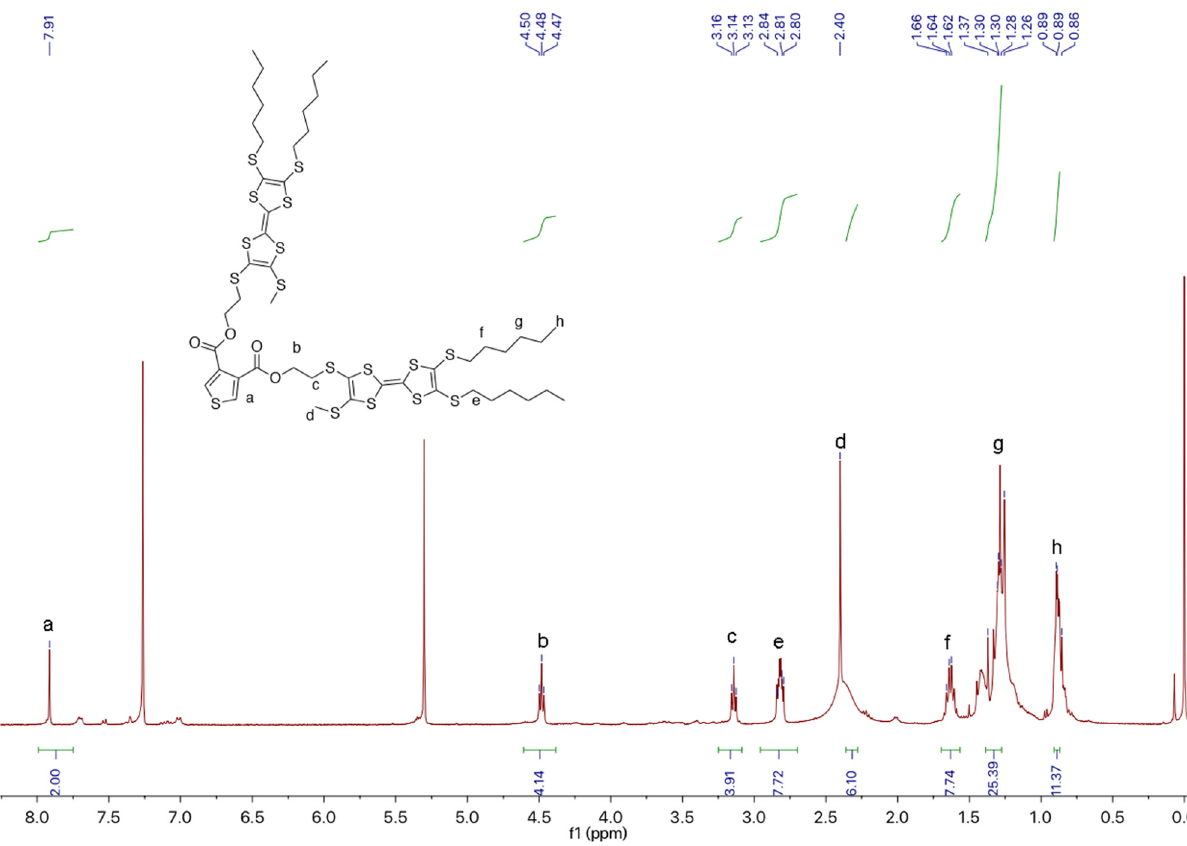
Figure A4: 1 H NMR of DTTF - Th.